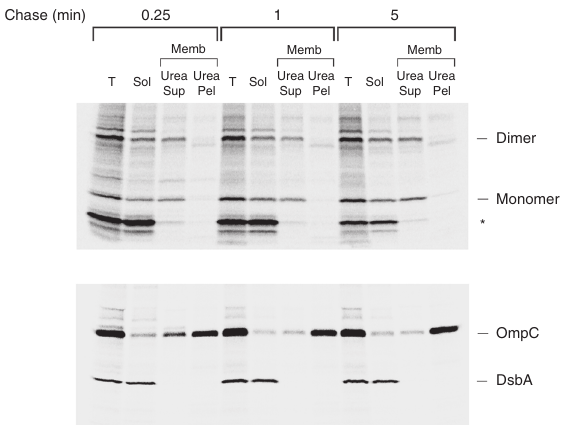
Fig. 7 Localization of the UpaG Δ 2(W1778A) crosslinking product. AD202 transformed with pRS13 [P rha - HA-upaG Δ 2(Y1135am/W1778A) ] and pDULE- Bpa were radiolabeled, UV irradiated and fractionated. Immunoprecipitations were conducted using an anti-HA antiserum (top gel) or anti-OmpC and anti-DsbA antisera (bottom gel). The truncated form of HA-UpaG Δ 2 that resulted from translation termination at the amber codon is denoted with an asterisk. T, total cell extract; Sol, soluble protein; Memb, cell membranes; Urea Sup, urea-soluble protein; Urea Pel, urea-insoluble